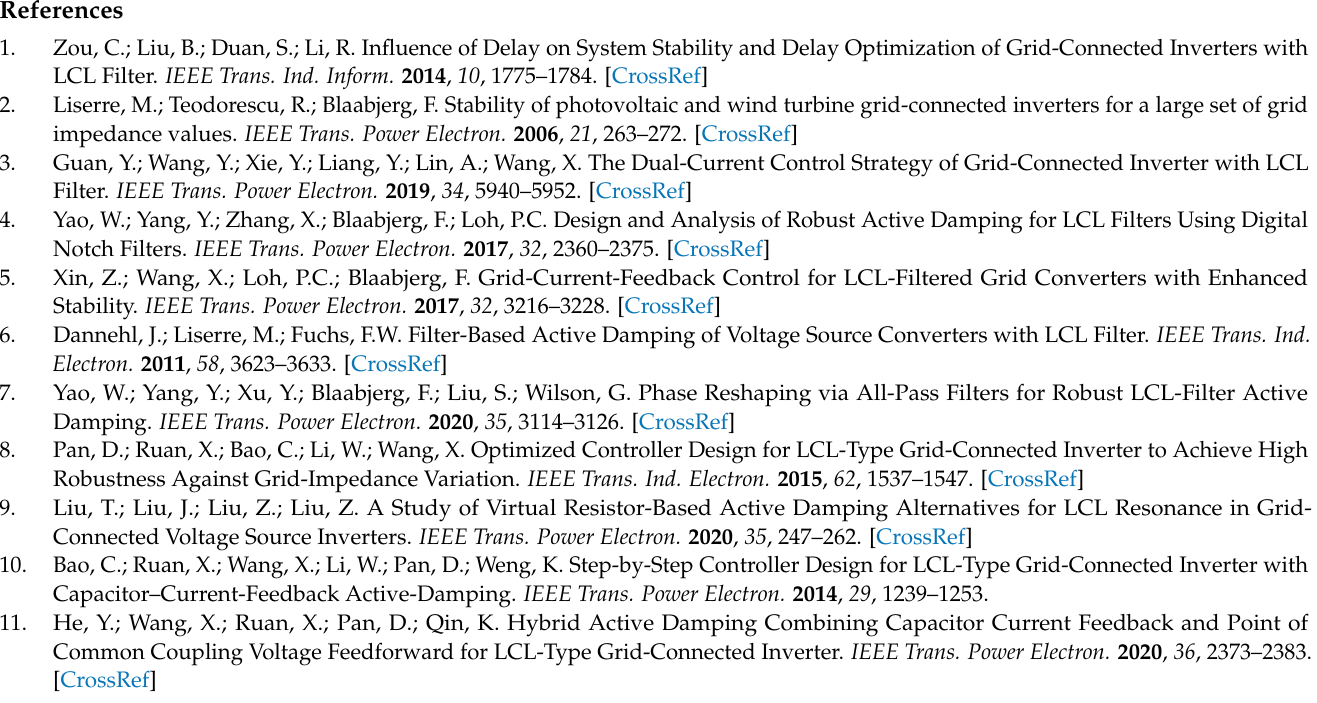
Figure A1. Equivalent block diagrams transformed from Figure 22, ( a – f ) show the simplification process of the control block